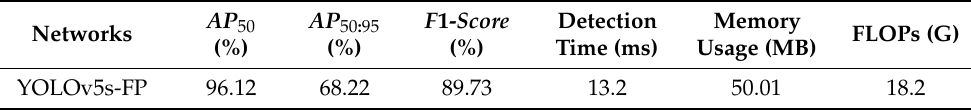
Table 2. Overview of accuracy, detection time, and computational cost of the YOLOv5s-FP.